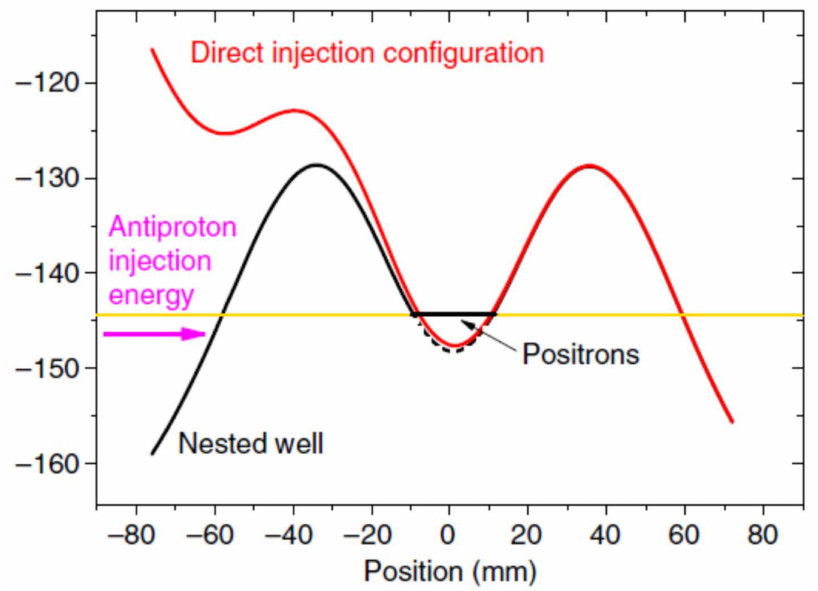
Figure 5. The concept of a nested-well configuration used to confine antiprotons and positrons in the same spatial region. The two-particle species, having opposite charges, see the potential with the opposite sign. Antiprotons are coming from the Antiproton Decelerator and are cooled and stored before the injection in the trap. Positrons come from radioactive sources and are also cooled and accumulated before mixing with antiprotons.